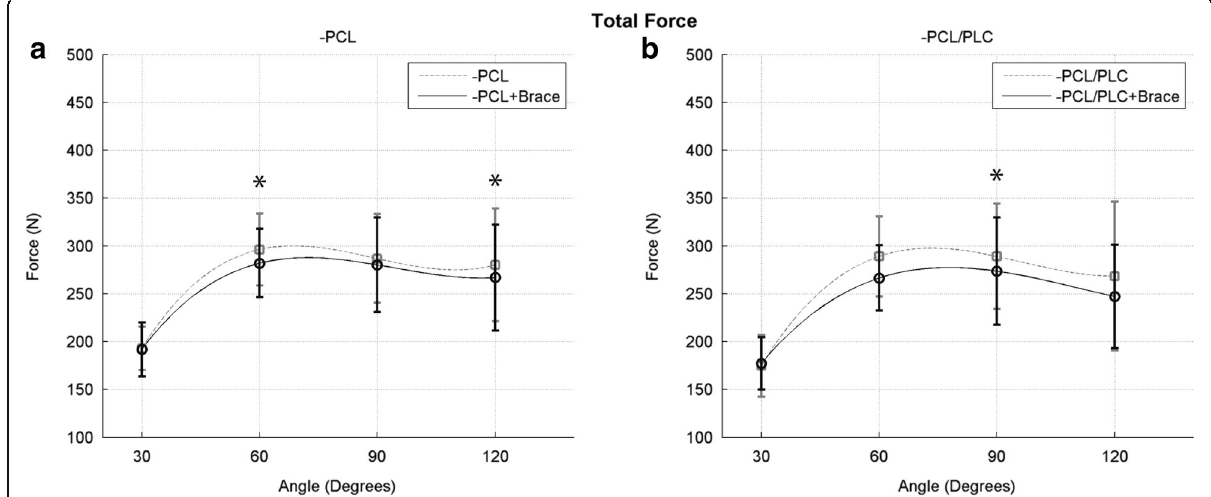
Fig. 2 Force in the PFJ as a function of knee flexion angle in the PCL-deficient state ( a ) and PCL/PLC-deficient state ( b ) with and without the use of a dynamic brace (*indicates p <